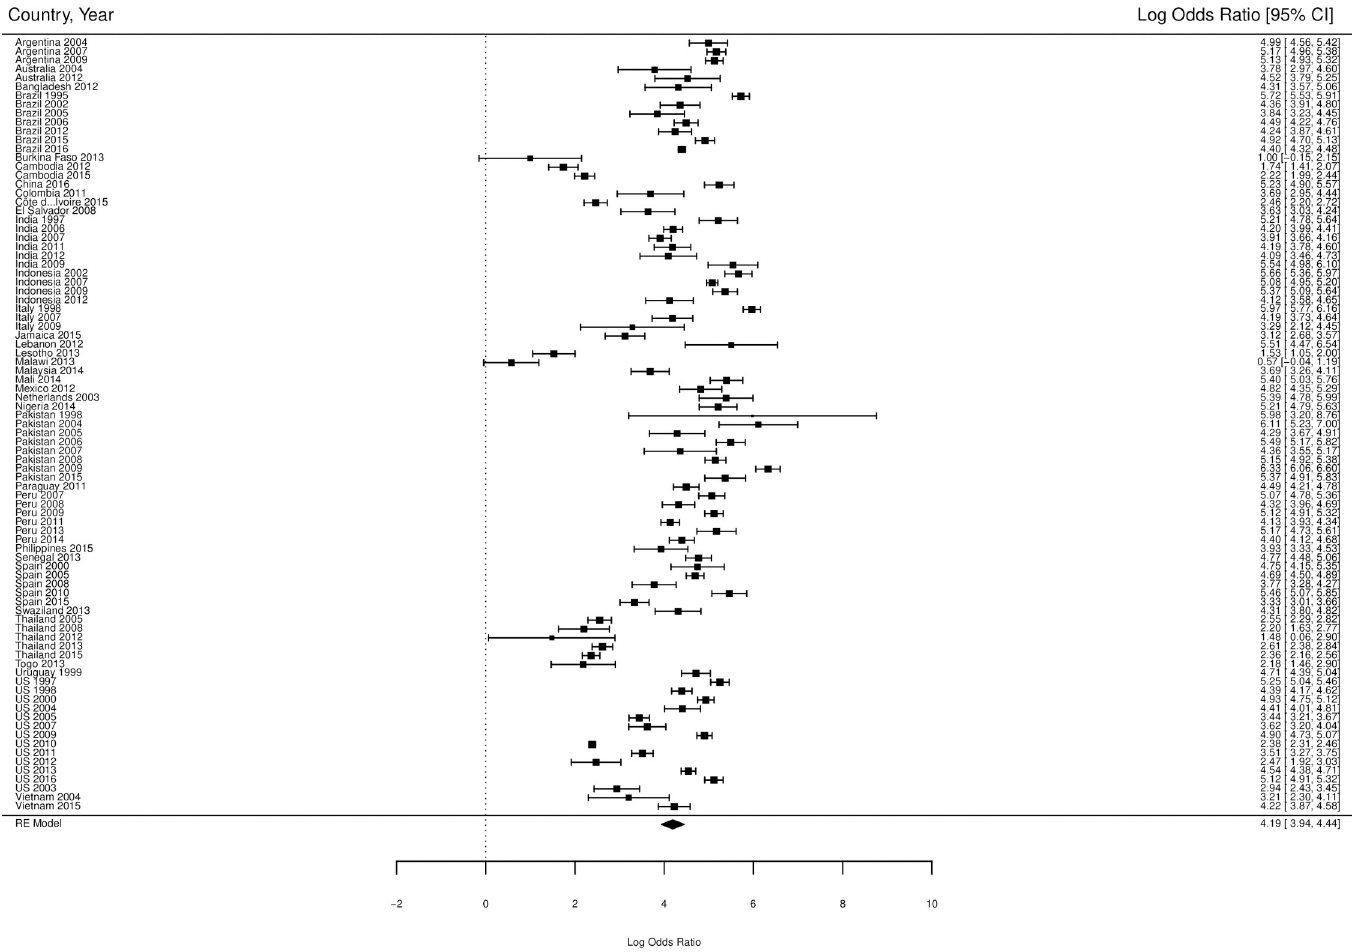
Fig 2. Forest plot of HIV prevalence in trans feminine individuals compared to all adults (age 15+). The scale on the x-axis is log odds ratio. The percentages indicate the weight of each country by year within the meta-analysis. The numbers in the right column are the log odds ratios including their confidence intervals. We converted these log odds ratios into odds ratios, as described in Table 2